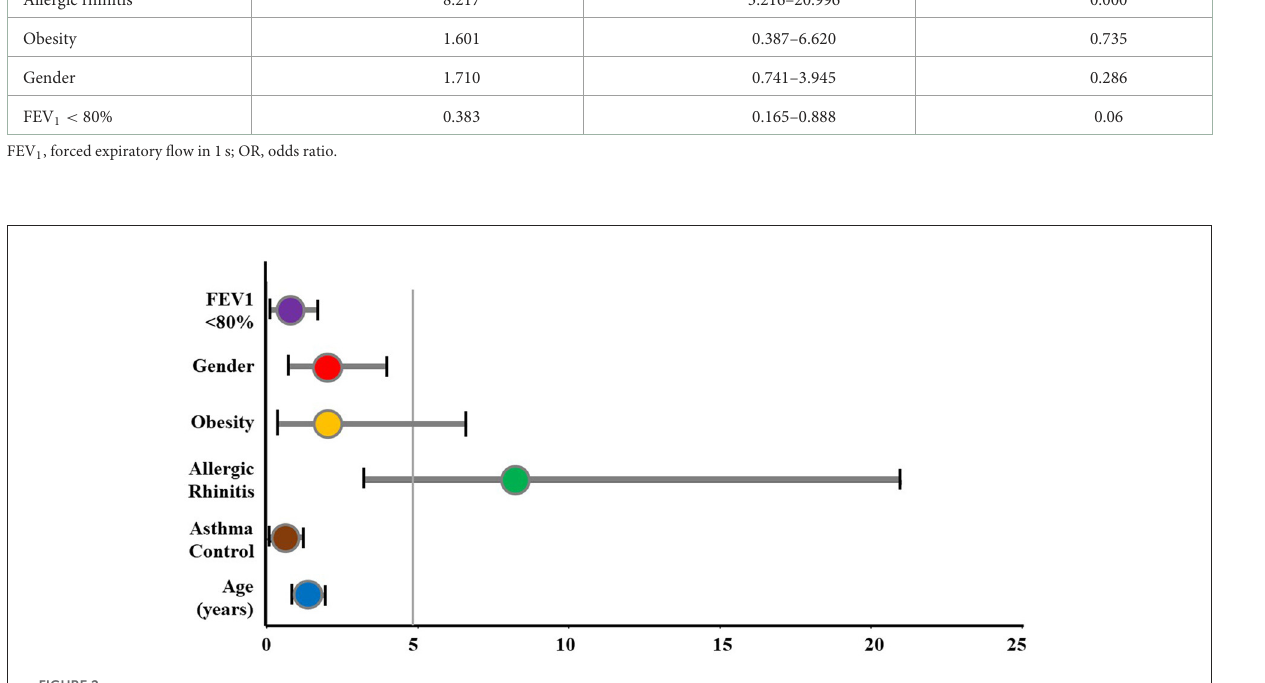
FIGURE2 The odds ratio of OSA for study subjects. FEV1, forced expiratory volume in 1s; OSA, obstructive sleep